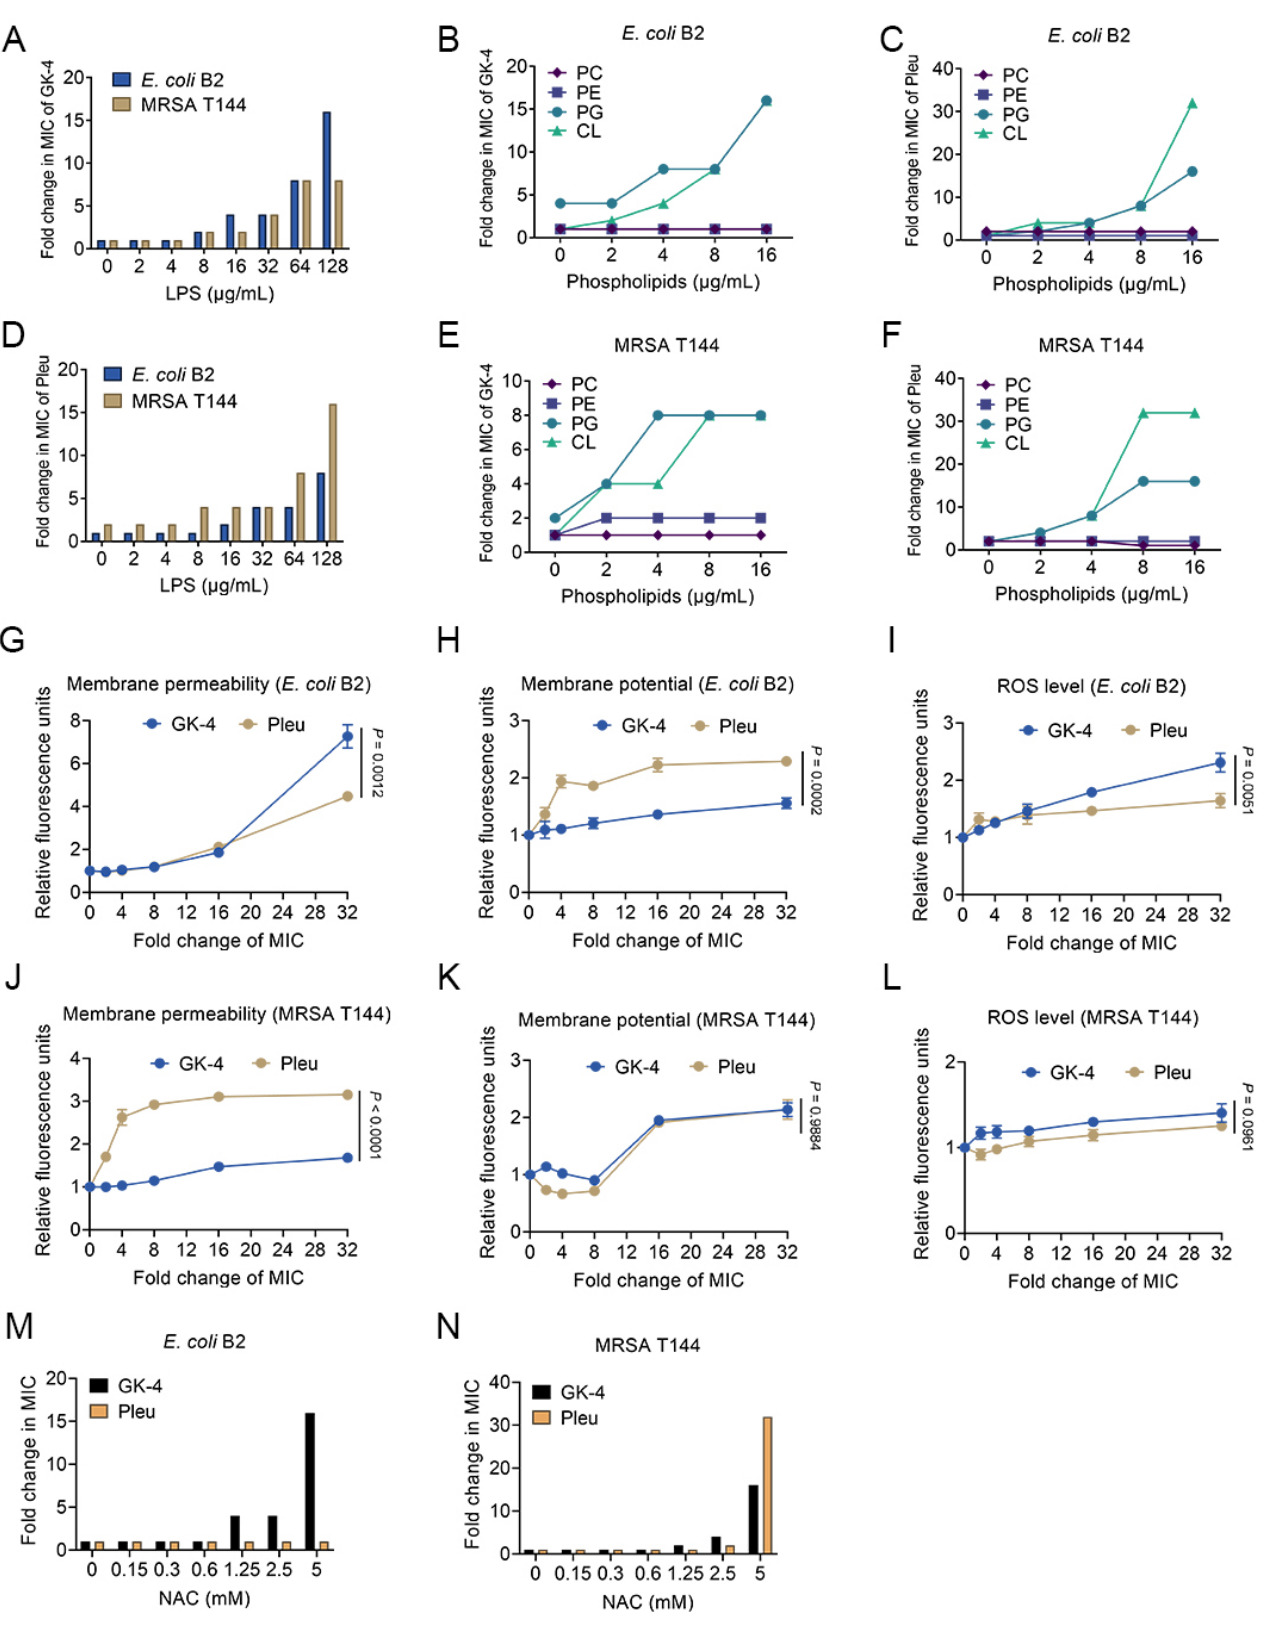
Figure 4. Antibacterial mechanisms of GK-4. ( A , D ) Exogenous addition of LPS deriving from E. coli O111:B4 impaired the antibacterial activity of GK-4 and Pleu against E. coli B2 and MRSA T144 in